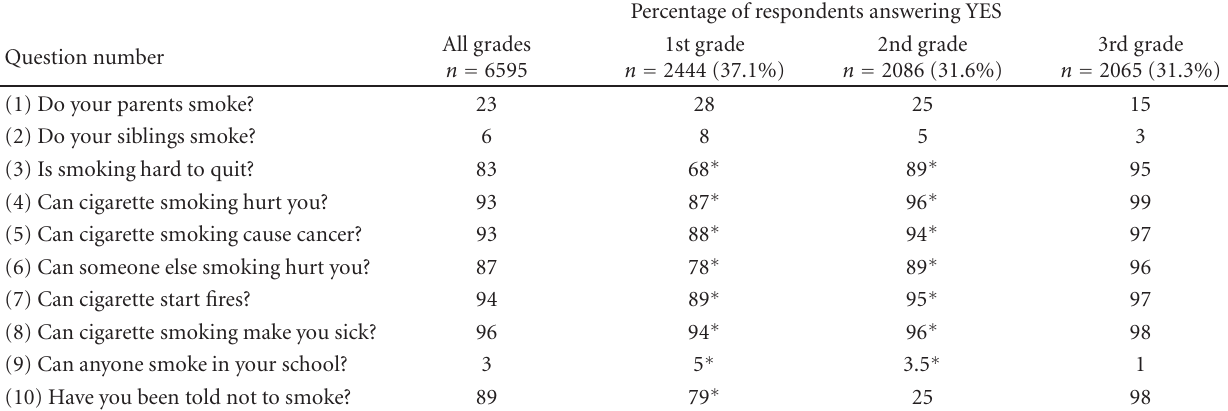
Table 1: Percentage of positive responses to prestudy questionnaire by grade.